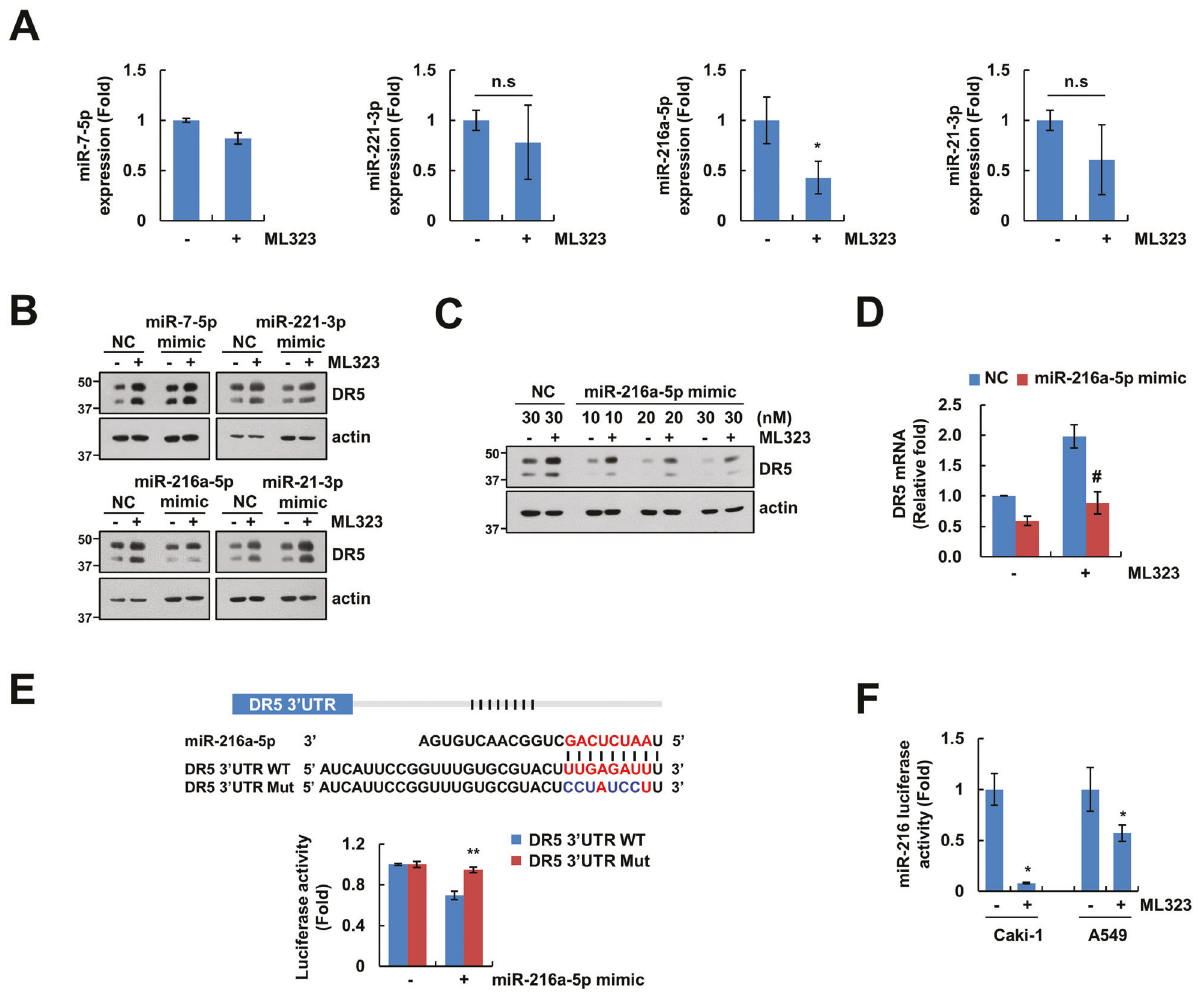
Fig. 4 Decrease of miR-216a-5p is involved in ML323-mediated DR5 mRNA upregulation. A Investigation of microRNAs in Caki-1 cells treated to 30 μ M ML323 for 24 h. B Caki-1 cells were transfected with miR-negative control (NC), miR-7-5p mimic, miR-221-3p mimic, miR-216a- 5p mimic, or miR-21-3p mimic followed by 30 μ M ML323 for 24 h. C, D Caki-1 cells were transfected with miR-NC or miR-216a-5p mimic followed by 30 μ M ML323 for 24 h. DR5 protein and mRNA expression were analyzed using western blotting ( C ) and qPCR ( D ). E Caki-1 cells were transfected with luciferase reporter gene for DR5 3 ′ UTR WT or mutant followed by 30 μ M ML323 for 24 h and analyzed using luciferase activity assay. F Caki-1 and A549 cells were transfected with miR-216 promoter plasmid followed by 30 μ M ML323 for 12 h. Protein expression was measured by western blotting ( B , C ). Values in the graphs ( A , D – F ) represent the mean ± SD of three independent experiments. * P < 0.01 compared to the control. # P < 0.01 compared to ML323 treated miR-NC-transfected group. ** P < 0.01 compared to miR-216a-5 mimic-treated DR5 3 ′ UTR